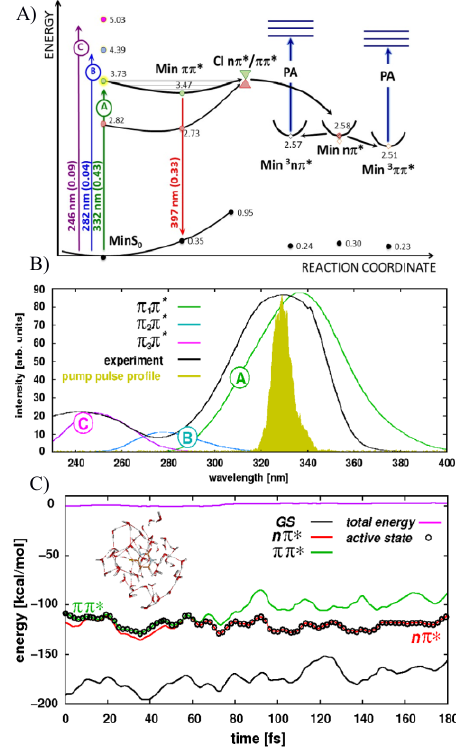
Fig 2. Computational results: a) Schematic picture of the ES deactivation processes; b) linear absorption spectrum of the lowest three bright ππ* transitions (green, blue and magenta), experimental spectrum (black), pump pulse spectrum (yellow dashed); c) a representative molecular dynamics